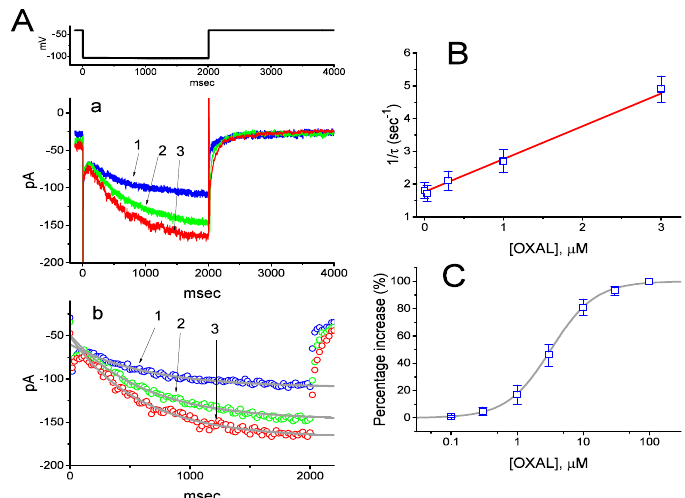
Figure 1. The e ff ect of OXAL on hyperpolarization-activated cation current ( I h ) recorded from pituitary GH 3 cells. ( Aa ) Representative whole-cell I h traces obtained in the absence (1) and presence of 1 µ M OXAL (2) or 0.3 µ M DEX (3). The upper part in ( A ) indicates the voltage protocol used. In ( Ab ), the activation time courses of I h taken in control (1) and during cell exposure to 1 µ M OXAL (2), and 3 µ M OXAL (3) were fitted by single exponentials (indicated by smooth lines) with values of 644, 612, and 585 ms, respectively. Notably, the data points for each trajectory were reduced for clarity. In ( B ), the reciprocal of activation time constant (i.e., 1 / τ ) versus the OXAL concentration was constructed and plotted. Data points shown in square circles were fitted by a linear regression, indicating that there is a molecularity of one. From minimum reaction scheme described in Materials and Methods, blocking ( k + 1 *) and unblocking ( k − 1 ) rate constants for OXAL-induced stimulation of I h were calculated to be 0.236 s − 1 µ M − 1 and 1.528 s − 1 , respectively. Mean ± SEM ( n = 8–11 for each point). ( C ) Concentration-dependent stimulation of OXAL on I h in response to membrane hyperpolarization (mean ± SEM; n = 9 for each point). Current amplitude was measured at the end of each hyperpolarizing pulse from − 40 to − 100 mV with a duration of 2 s. The continuous line overlaid onto the data points was fitted by the Hill equation, as detailed in Materials and Methods.